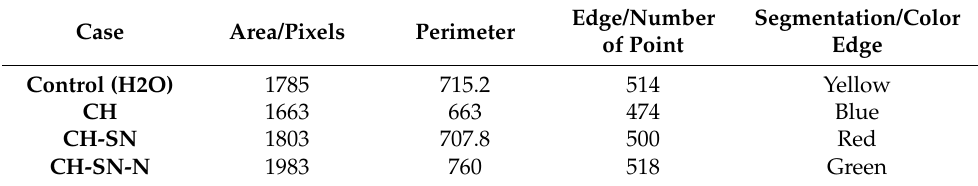
Table 5. Morphological characteristics of blueberry’s